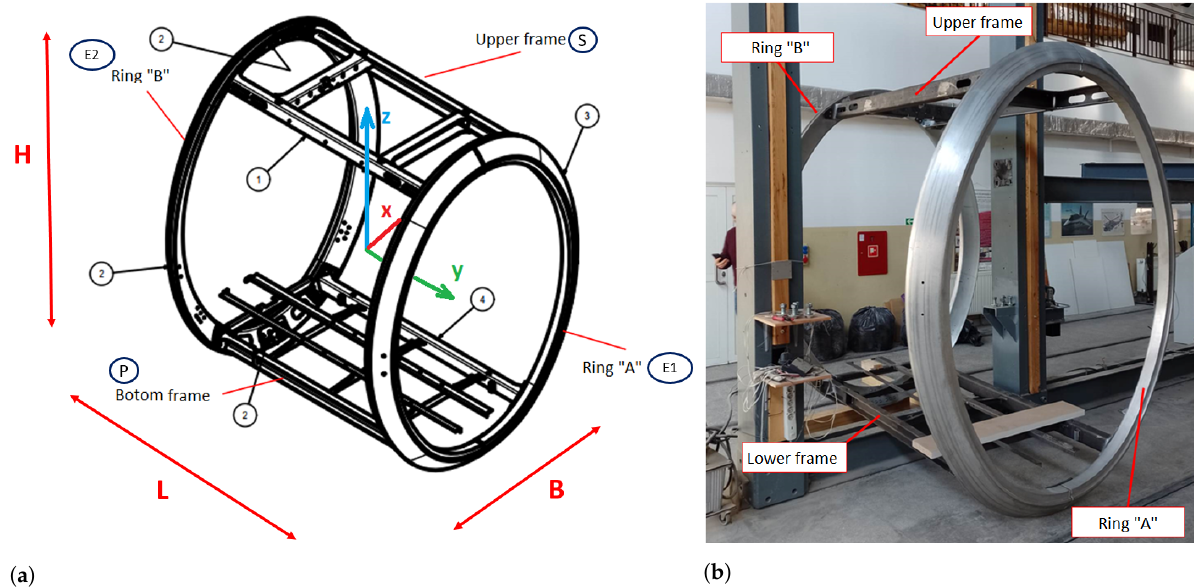
Figure 3. An illustrative drawing ( a ) and a photo ( b ) of a cableway gondola (research facility) with the most important construction elements marked (L—length, B—width, H—height).